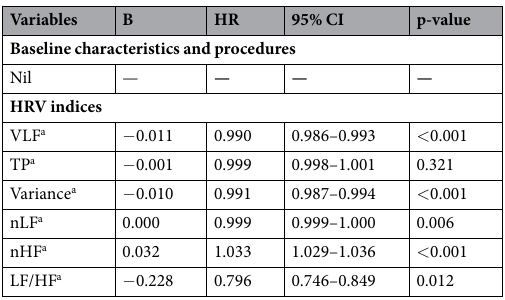
Table 3. Independent predictors for cardiovascular mortality after an 8-year follow-up. Note: All HRV measurements had been adjusted by mixed models and subsequently put into a multivariate Cox regression method with adjustment to baseline characteristics and clinical variables. In the mixed model, VLF, TP, and nLF were adjusted by times (HRV-0, -1, -2, -3); Variance was adjusted by times (HRV-0, -1, -2, -3) and comorbidities with peripheral arterial disease; nHF was adjusted by times (HRV-0, -1, -2, -3) and age; LF/HF was adjusted by times (HRV-0, -1, -2, -3), age, and blood urea nitrogen. a Every increment of one unit. Units: Ln (ms2) in VLF, TP, and variance; Ln (ratio) in LF/HF ratio; normalized units in nLF and nHF. Abbreviations: B, beta coefficient; CI, confidence interval; HR, hazard ratio; HRV, heart rate variability; Ln, nature logarithmical; nHF, normalized high-frequency; nLF, normalized low-frequency; TP, total power; Variance, the variance of the R-R intervals; VLF,